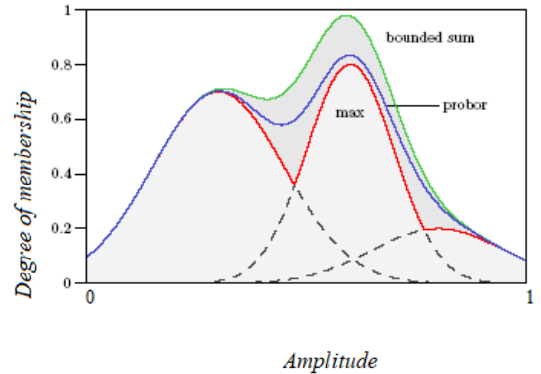
Figure 8. Three methods of fuzzy set aggregation.